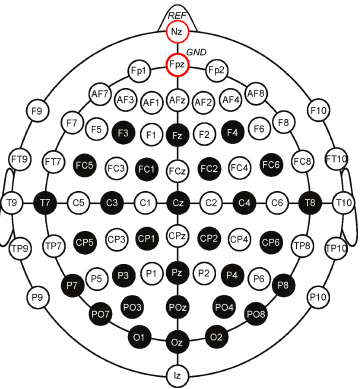
Figure 1. The 10–20 electrode system of the International Federation